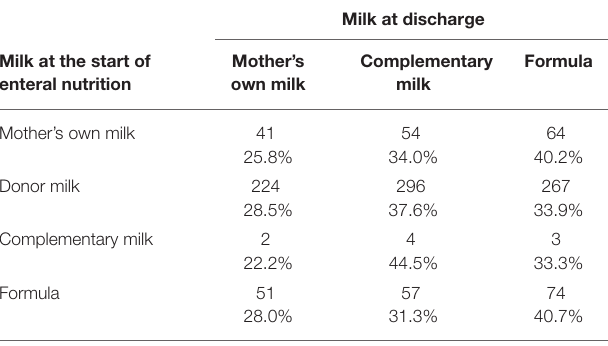
TABLE 4 | Type of milk at discharge home by type of milk at the start of enteral